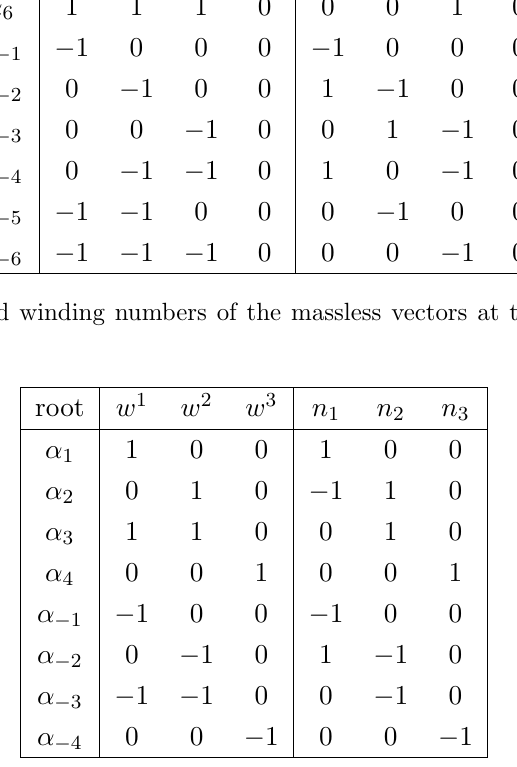
Table 10 . Momentum and winding numbers of the massless vectors at the [SU(3) (cid:2) SU(2)] L (cid:2) [SU(3) (cid:2) SU(2)] R enhancement point of T 3 . from (cid:11) ; such as (cid:11) ; i = (cid:6) 6 ; (cid:6) 7). The rest of the vectors remain massless and are identi(cid:12)ed 3 i with the ones of SU(3) (cid:2) SU(2). The coordinates of the two tori are identi(cid:12)ed as x 1